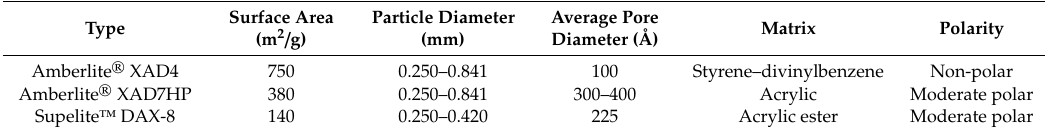
Table 5. Physical properties of the selected macroporous